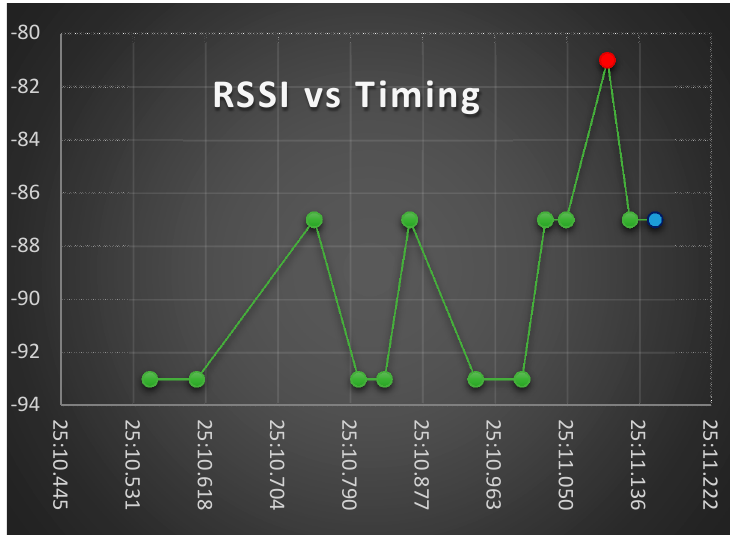
Figure 14. The RSSI on the BLE Receiver related to the receiving time. Table 2. The dynamic experiment when the Tx power of the BLE Tag on the chest is set at Level 3. On Chest Tx Level 3